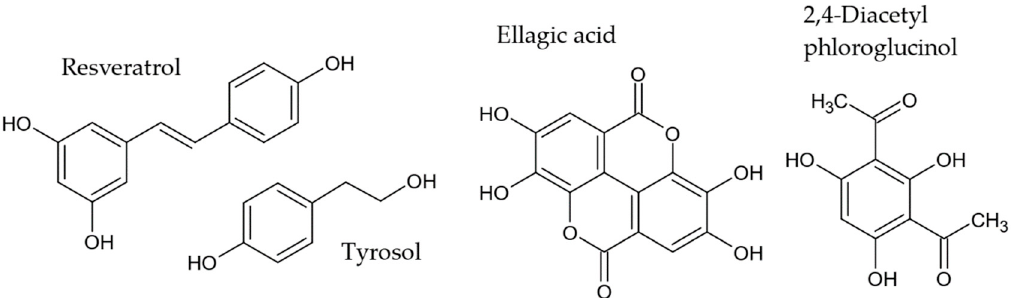
Figure 6. Other antiAGEs phenolic compounds reported in endophytes.